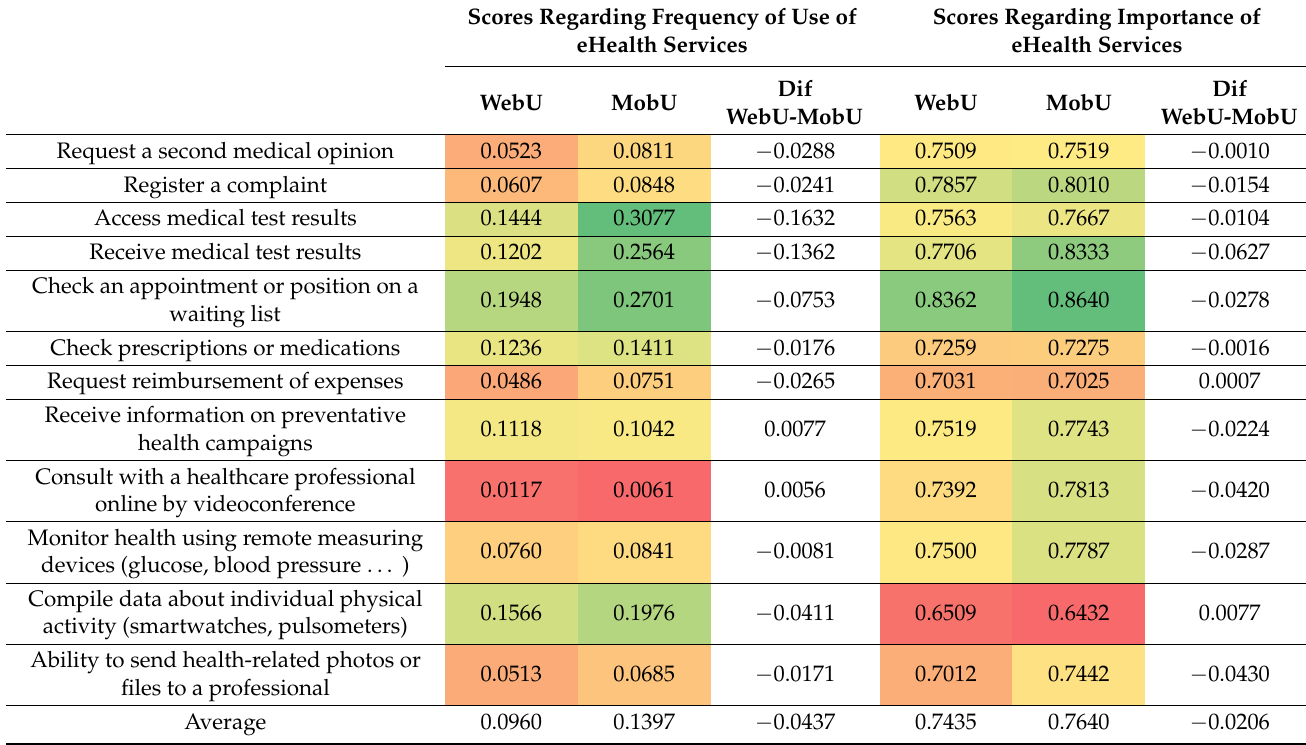
Table 3. Frequency and importance of eHealth services (by user profile).